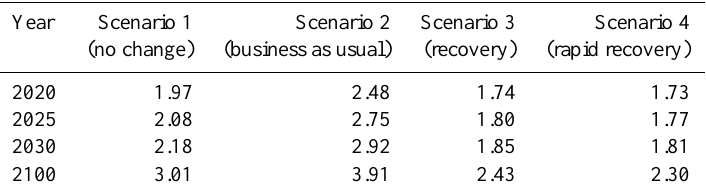
Table 2. Cumulative subsidence (m), modelled including creep behaviour, for 4 groundwater management scenarios for Jakarta, Indonesia, by Bakr (2015). Because of the slow creep rates, subsidence continues even after hydraulic heads are restored (scenarios 3 and